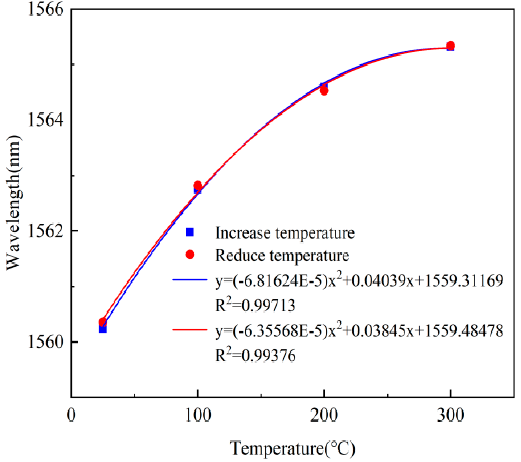
Figure 10. The relationship between the wavelength and the operating temperature. The nonlinearity of the fiber-optic Fabry–Perot pressure sensor is tested at 25 ◦ C, 100 ◦ C, 200 ◦ C, and 300 ◦ C, respectively. The applied pressure is changed from approximately 0 MPa to 0.5 MPa, with a step size of 0.05 MPa. The relationship between the peak wavelength and the pressure of the sensor at different temperatures is shown in Figure 11. It can be observed in Figure 11 that the sensitivity of the sensor increased with the temperature, which is determined by the relationship between the Young’s modulus of the material and temperature. When the temperature reaches 300 ◦ C, the sensitivity of the sensor is 57.908 nm/MPa.